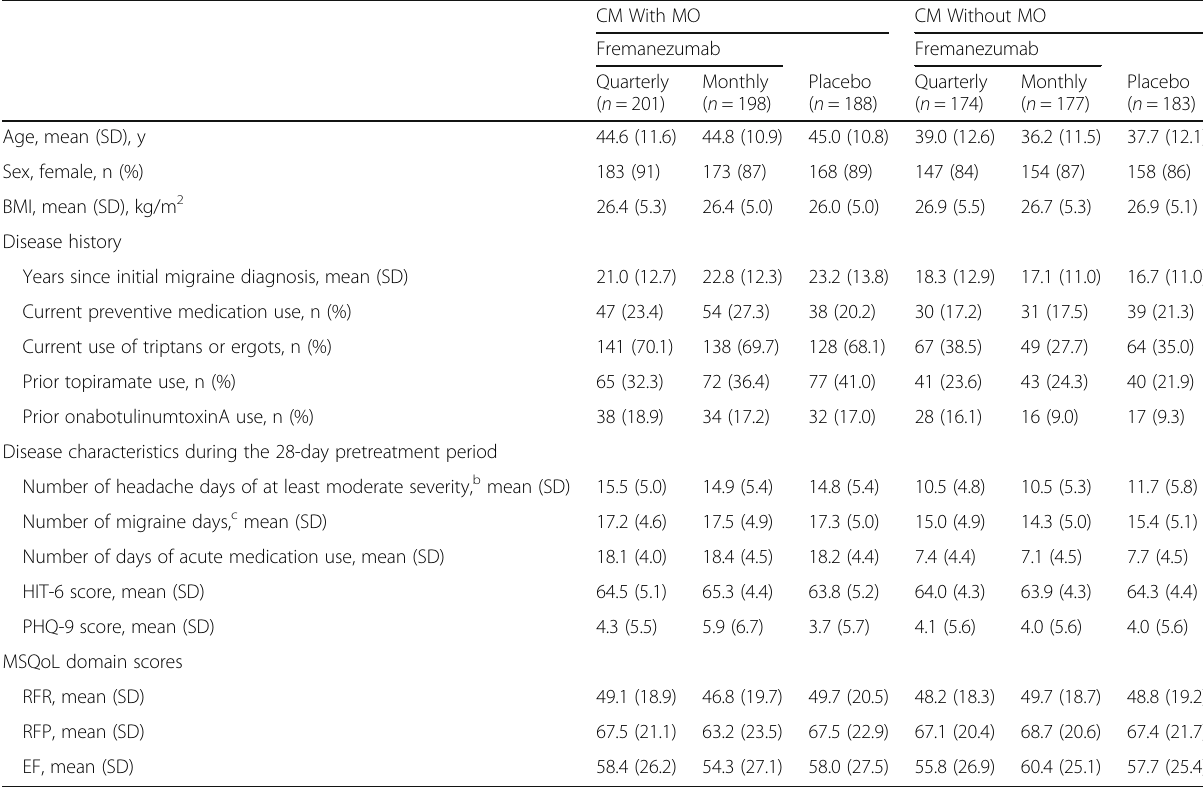
Table 1 Demographics and baseline characteristics with and without MO a